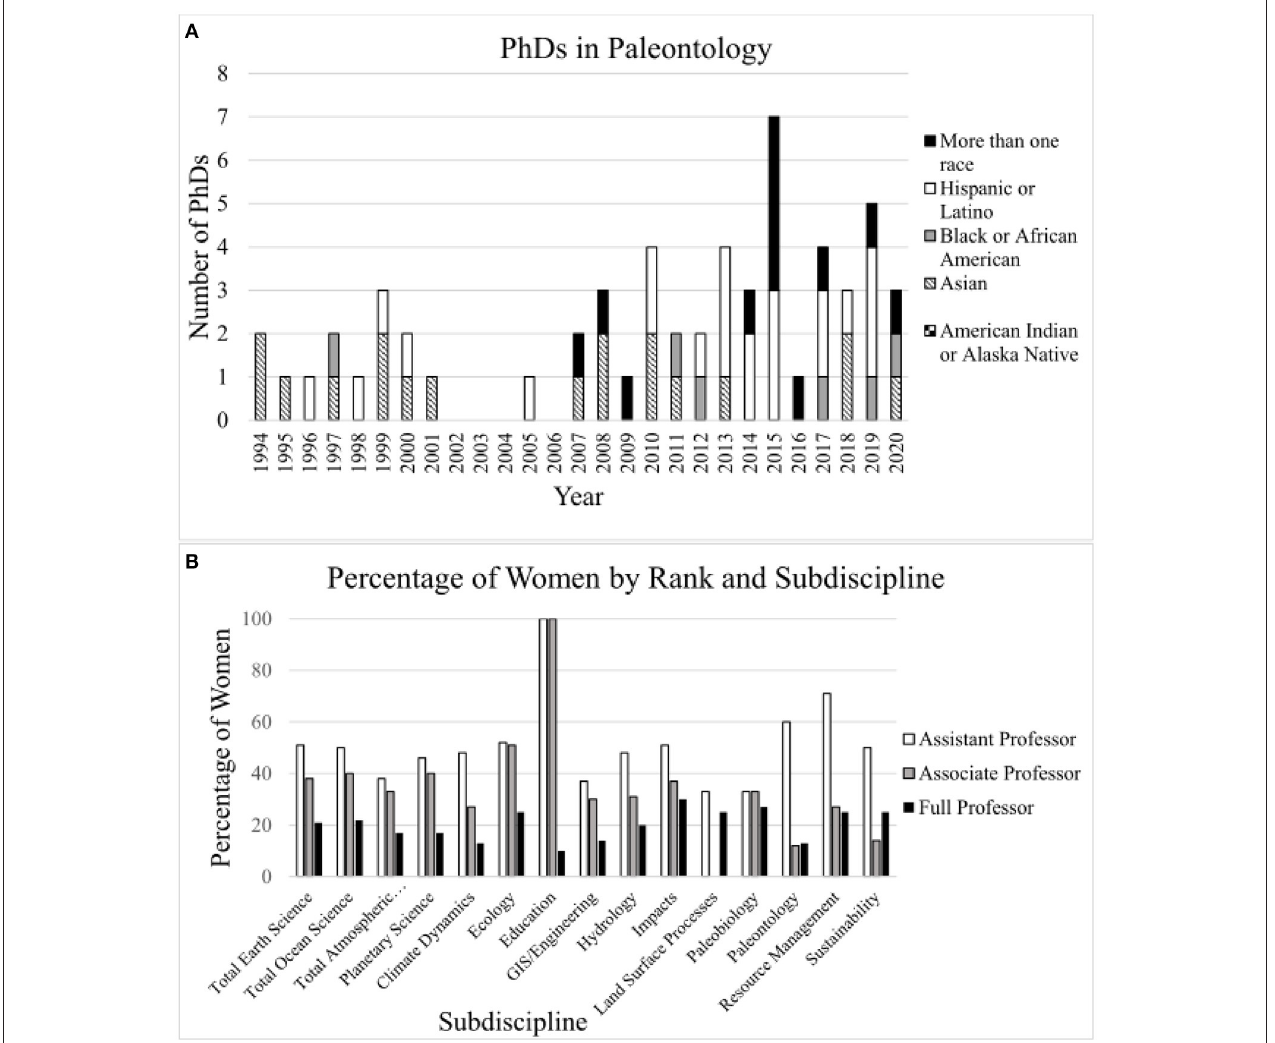
FIGURE 1 | (A) PhDs awarded to paleontologists in the U.S. 1994–2020 (Kang, 2021). (B) Percentage of women in geoscience subdisciplines at 62 U.S. universities ( Ranganathan et al.,